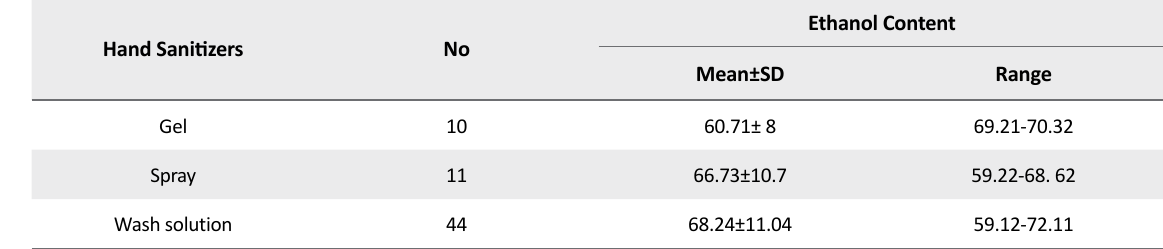
Table 4. Mean recovery percentage for various levels of spiked ethanol in gel, spray, and washing solution